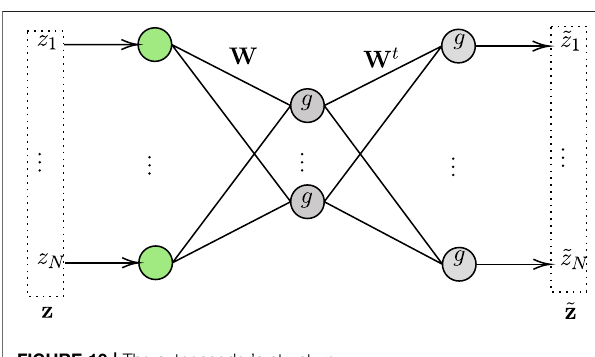
FIGURE 10 | The autoencoder ’ s